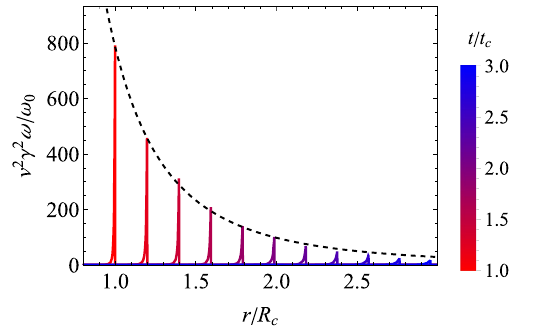
Fig. 3 Time evolution of the perfect fluid stress energy tensor (solid lines) together with the r − 3 scaling for comparison (dashed line). The red profile is the initial condition just after the bubble collision t c and darker colours show the profile at later times. The parameters for this example profile are α = 20 and γ w = 50 corresponding to a very strong transition such that the velocity of the profile remains nearly constant and only very slowly changes to the speed of